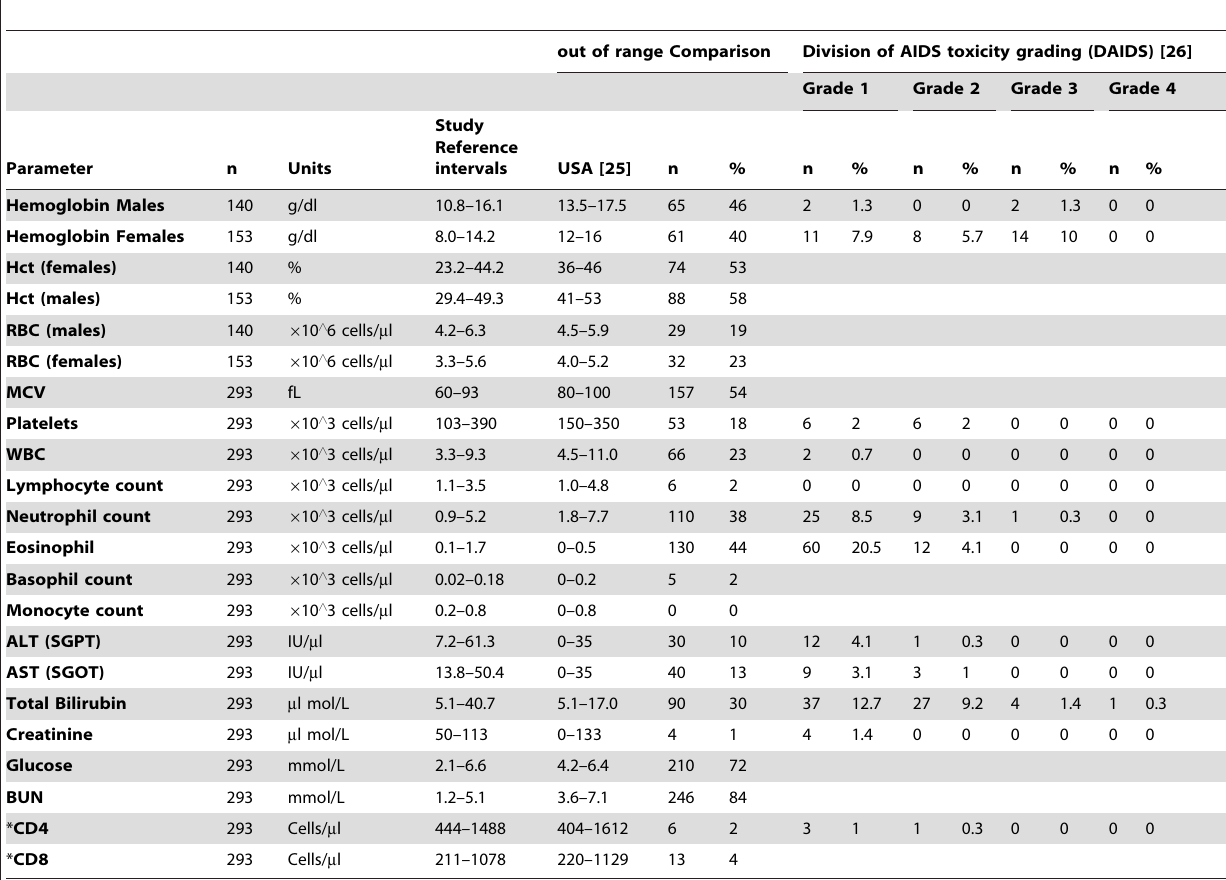
Table 3. Out of range and frequency of adverse events in the rural western Kenyan cohort obtained from comparison with values from DAIDS and North American derived MGH